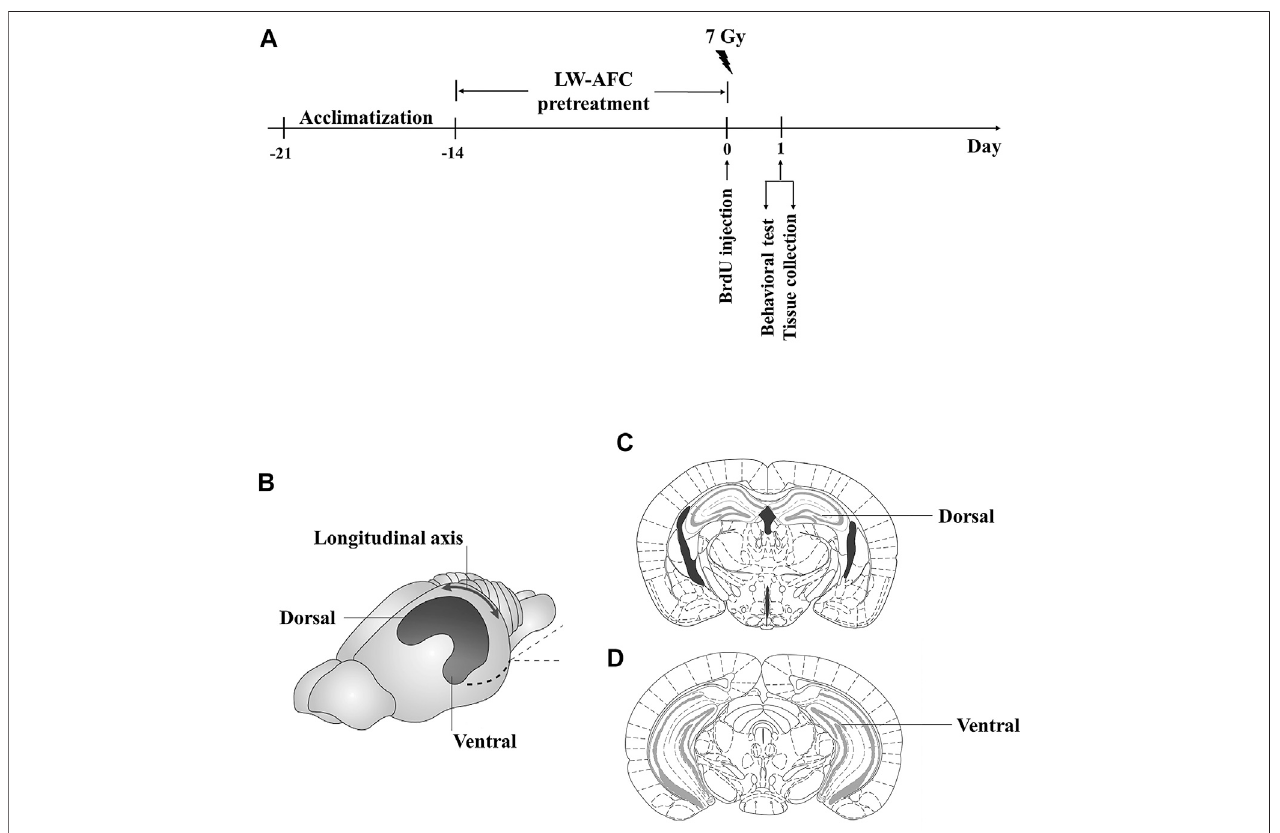
FIGURE 2 | Scheme of the experimental procedure and schematic representation of the dorsal and ventral hippocampus in mice. (A) Scheme of the experimental procedure. (B) The image of the dorsal and ventral hippocampus along the longitudinal axis. (C) The coronal brain section of the dorsal hippocampus. (D) The coronal brain section of the ventral